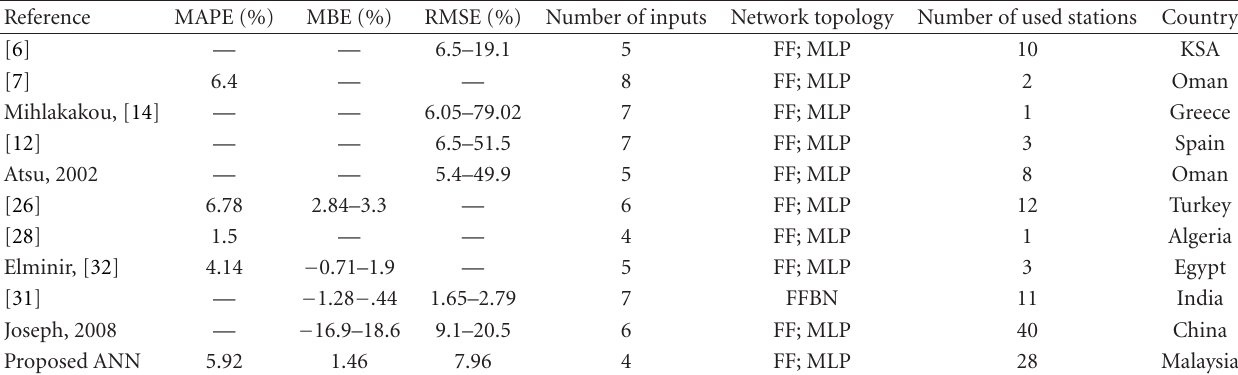
Table 6: Comparison with previous work.